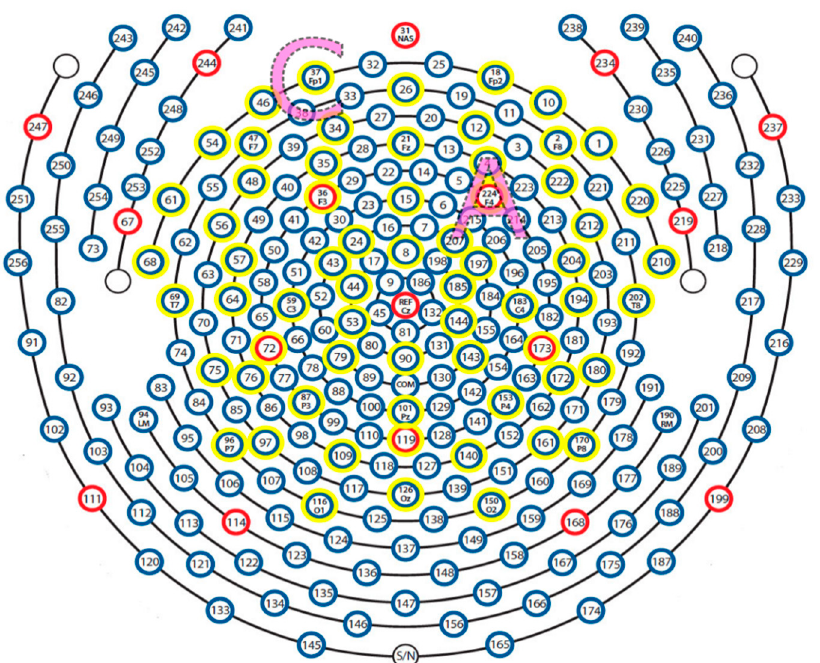
Figure 3. 256-channel electroencephalogram (EEG) net with illustrated anatomical placement of tDCS anode (A) and cathode (C). The 64 channels used in the event-related potentials (ERP) analysis are highlighted in yellow. Anterior (top), posterior (bottom), vertex (central), left, and right, as shown in the illustration. The net was removed for the 30-min tDCS or sham intervention and replaced for the post-intervention ERP recording. The tDCS anode and cathode were placed at the site of electrodes F4 and Fp1, respectively, according to the International 10–20 EEG system. Two inhibition-related ERP components were investigated in this study: N2 and P3. The amplitude of the N2 ERP component was defined as the minimum of individual average ERP data within the time window of 140–270 ms after stimulus onset. P3 component am- plitude was defined in the window of 250–450ms in the same electrodes cluster. Fourteen frontal electrodes were chosen for both N2 and P3 analysis, which included Fp1, Fp2, Fz, F3, and F4 electrodes in the 10–20 system. The amplitude peak was computed based on the average of this electrode cluster. Only ERP data associated with a correct behavioral response were used in the statistical test analysis. The ERP waveform with N2 and P3 components on channel Fz was illustrated in Figure 4.